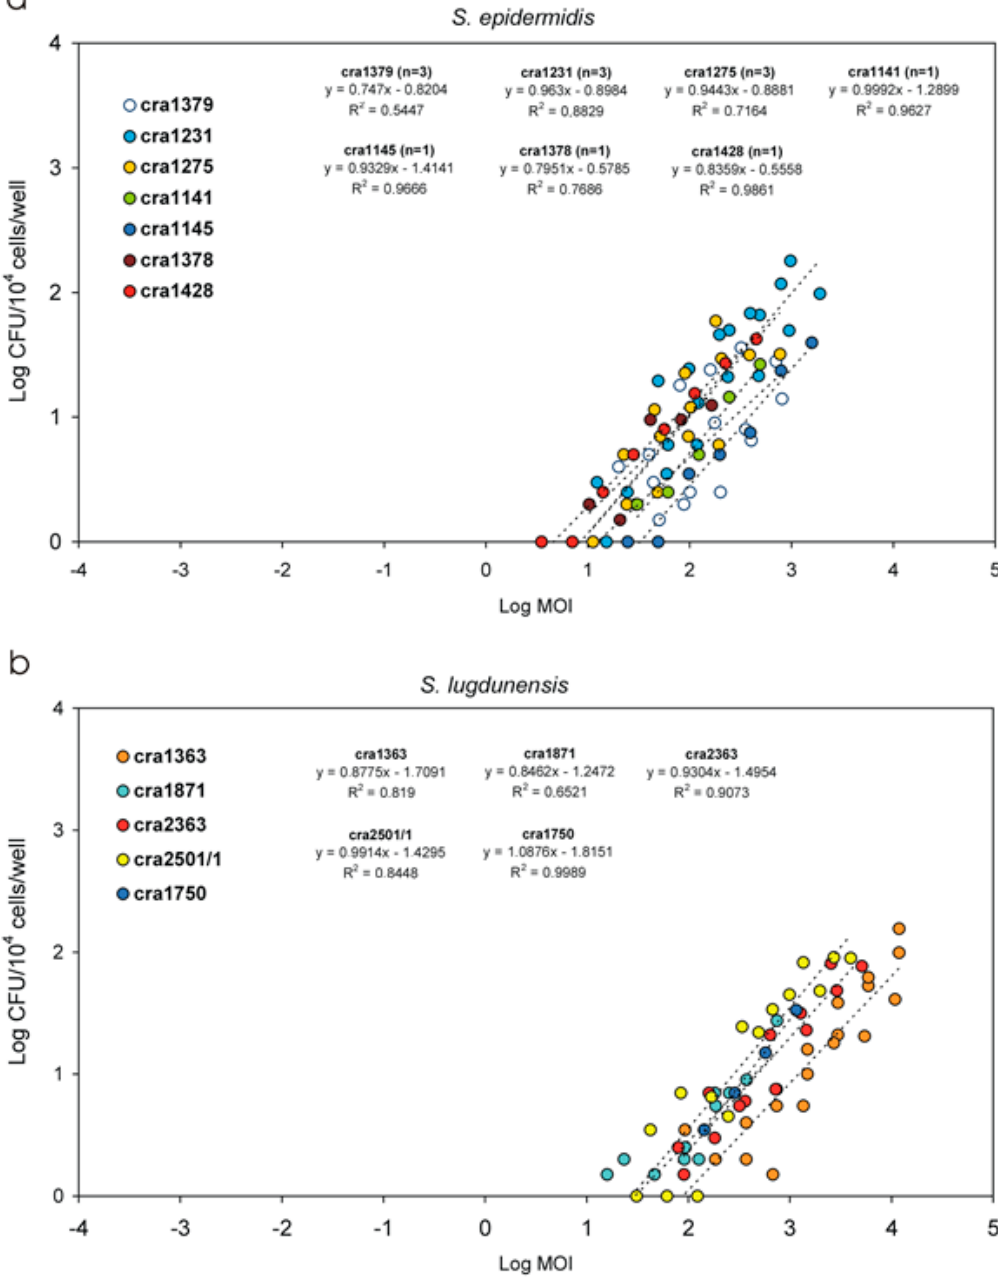
Figure 9. Log CFU vs. Log MOI linear regression curves: S. epidermidis strains ( a ); and S. lugdunensis strains ( b ).